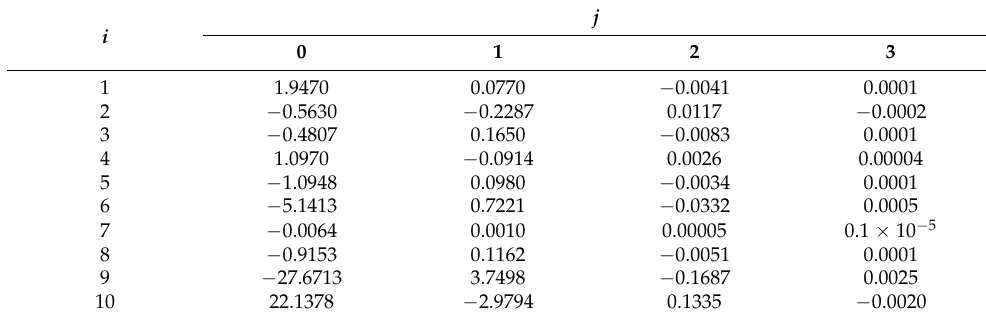
Table 6. Results for the parameters β m,i